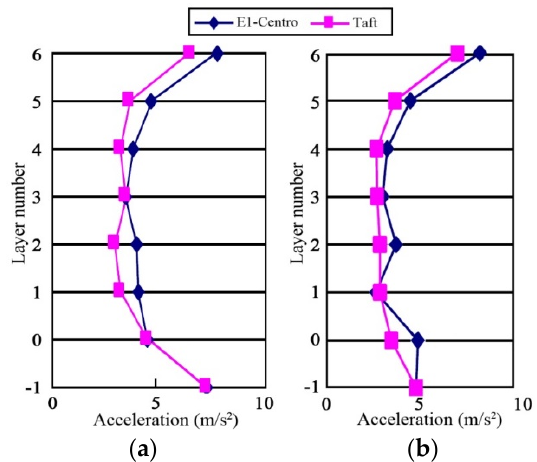
Figure 12. Acceleration peak curves under rare intensity. ( a ) By continuity control mode; ( b ) By switch control mode.